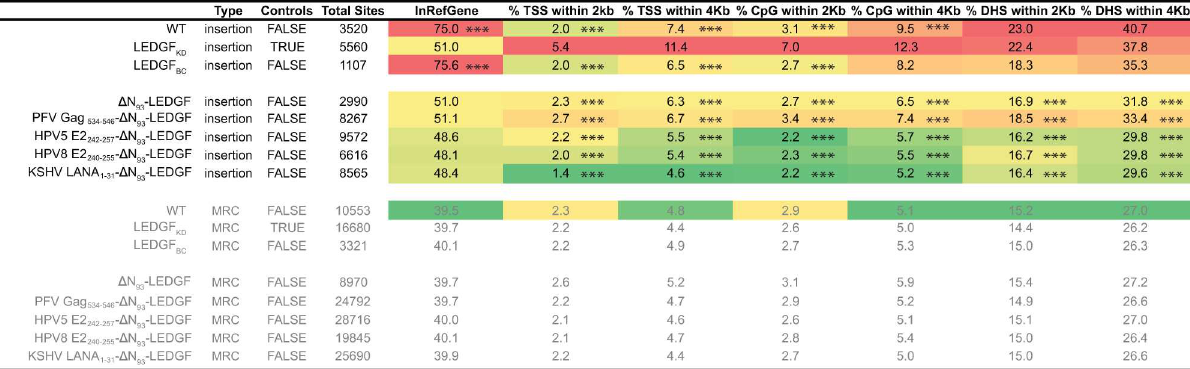
Fig 5. Integration frequency near genomic features. Fig showingthe percentageHIV-derived lentiviral vector integrationsites relative to features specific for integrationviral vectors such as integrationinto the body of genes (Refseq genes, InRefGene), integrationwithin 2kb-4kb windows near Transcription Start Sites (X5-end of genes, TSS), midpoint of CpG islands or DNase I-hypersensitive sites (DHS), counted in both the 5’ and 3’ direction. Dataset details are describedin the MM section. Asterisks depict a significant deviationfrom LEDGF KD (two-tailedChi-squaretest; *** , p-values < 0.001). TSS, Transcription start sites; DHS, DNase I-hypersensitive sites; PFV, Prototype foamy virus; HPV, Human papillomavirus; KSHV, Kaposi’s sarcoma herpes virus; LANA, Latency associated nuclear antigen; MRC, matched random